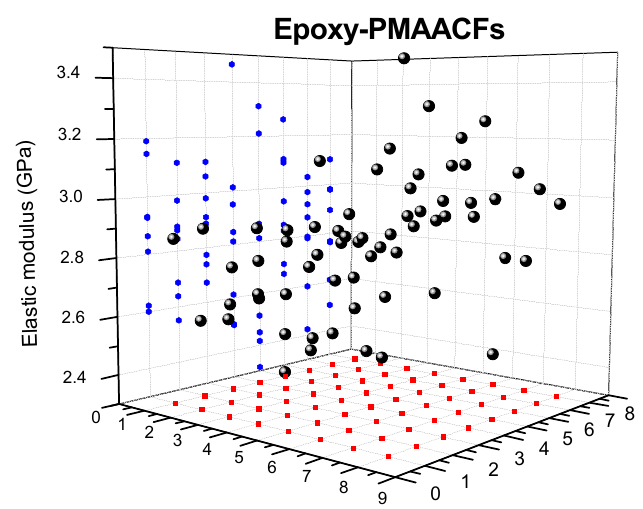
Figure 11. Elastic modulus obtained from the loading ‐ unloading mapping measurements at 200 nm of displacement for the epoxy ‐ PMAACFs sample.